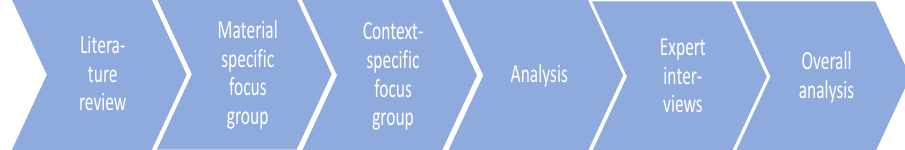
Figure 1. Overview of steps in method.